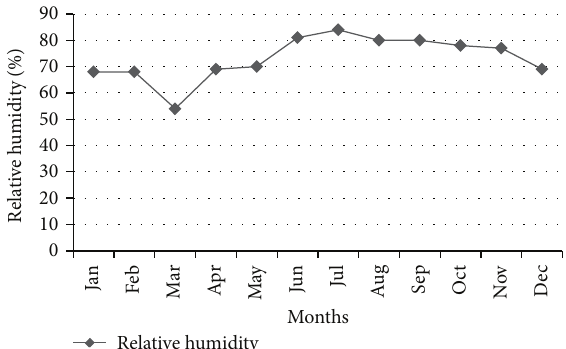
Figure 3: Relation among water demand, supply, and deficit in Dhaka City [1].